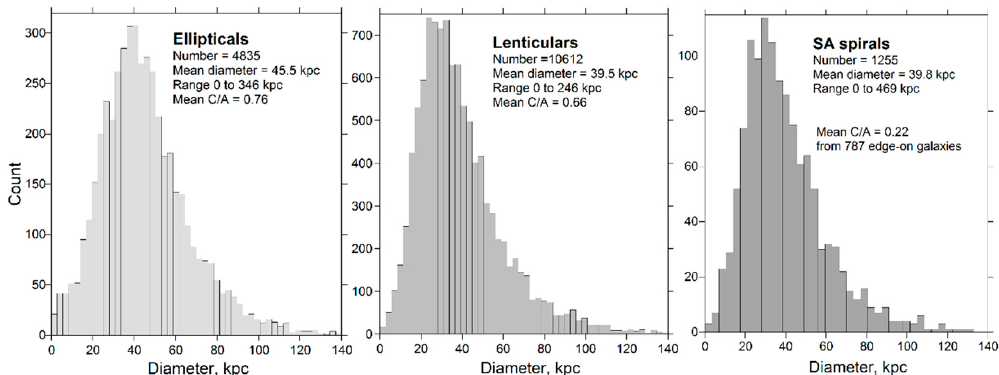
Figure 9. Histograms of important galaxy types. Data were mined from NED [42] in the stated groupings. The elliptical category was trimmed of all types except those labeled E, which mostly removed very small galaxies, although the mean was little affected. The lenticular download was cleaned of types that are likely spirals, such as SA0/a, which are represented in the SA group. For each of the ellipticals and lenticulars, C/A was determined from a smaller subset, and for the spirals the edge-on category of NED [42] was used. Due to being flat, the spirals with the same A as the ellipticals have much lower volume. The similar shapes of these skewed histograms reveals that similar processes are common to all, see Apostle [49] for a discussion of the link of mathematics of histograms to the underlying physics.